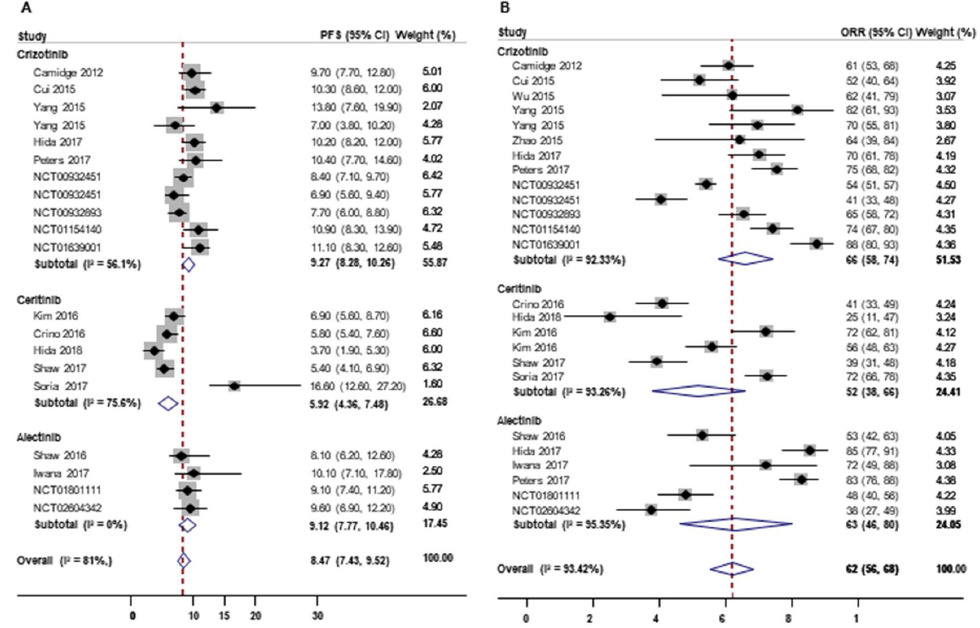
Figure 3. Efficacy of ALK inhibitors in treatment of ALK-positive non-small cell lung cancer (NSCLC) by type of outcome and type of ALK inhibitors. ( A ) PFS, progression-free survival (months), ( B ) ORR, overall response rate (%).